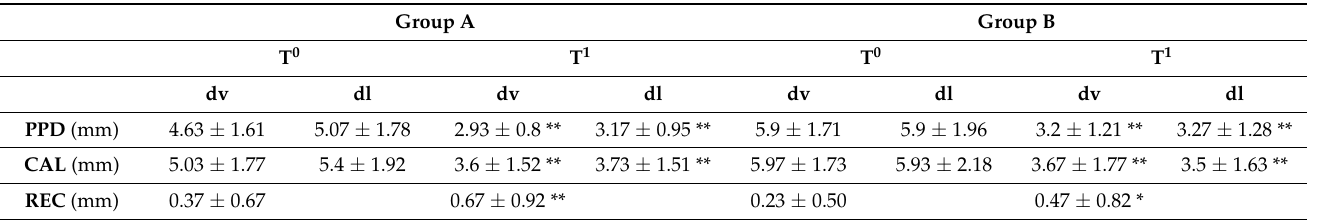
Table 2. Comparison of periodontal values (mean + standard deviation) preoperatively and 6 months after of each